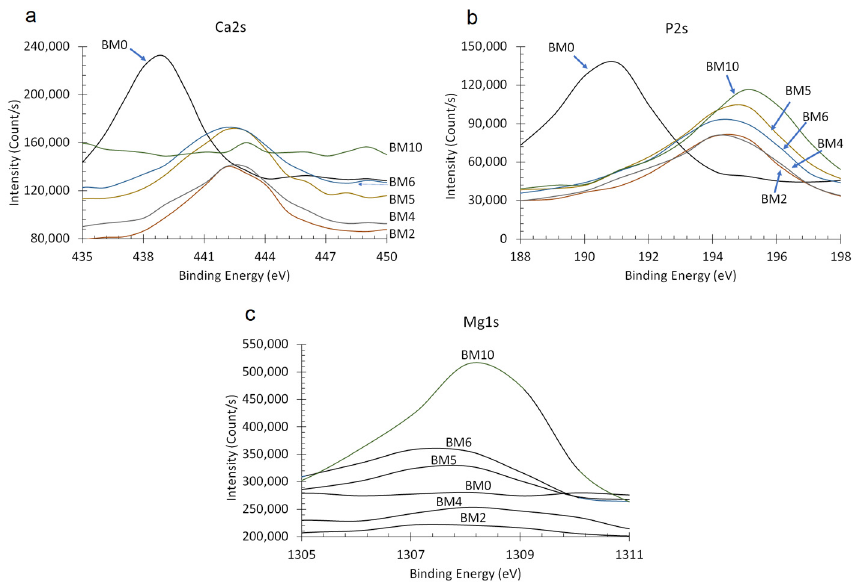
Figure 6. XPS analysis of the chemical state of ( a ) P2s, ( b ) Ca2s, and ( c ) Mg1s in Ca 1 − x Mg x ·HPO 4 ·nH 2 O compounds.